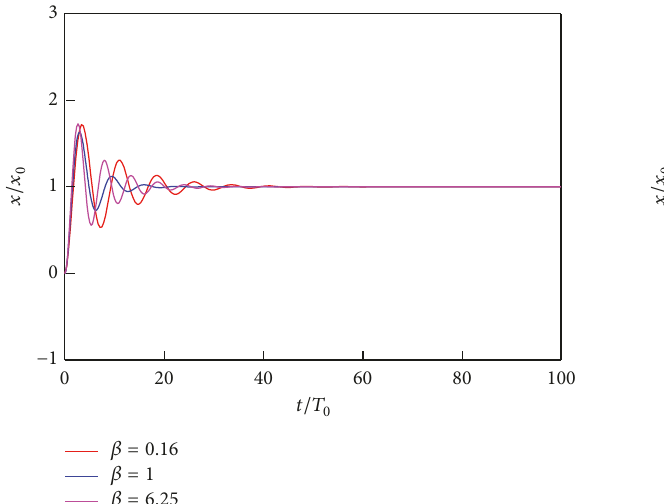
Figure21:Responseinthetimedomain (𝛼 = 1.5, 𝛽 = 0.16, 1,6.25) .